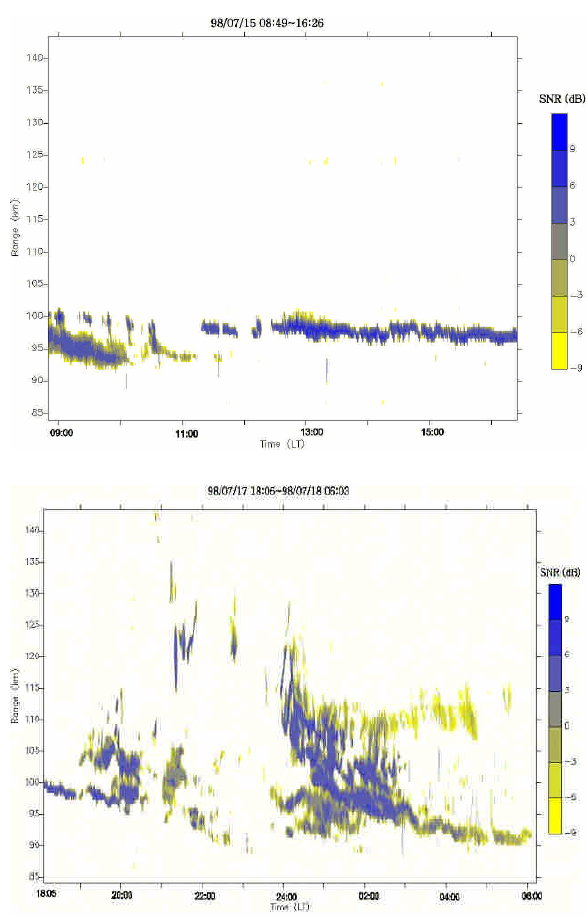
Fig. 1. Typical range-time signal-to-noise ratio (SNR) values ob- tained from the daytime lower E-region irregularities observed on 15 July 1998 (upper panel) and from the nighttime irregularities on 17 July 1998 (lower